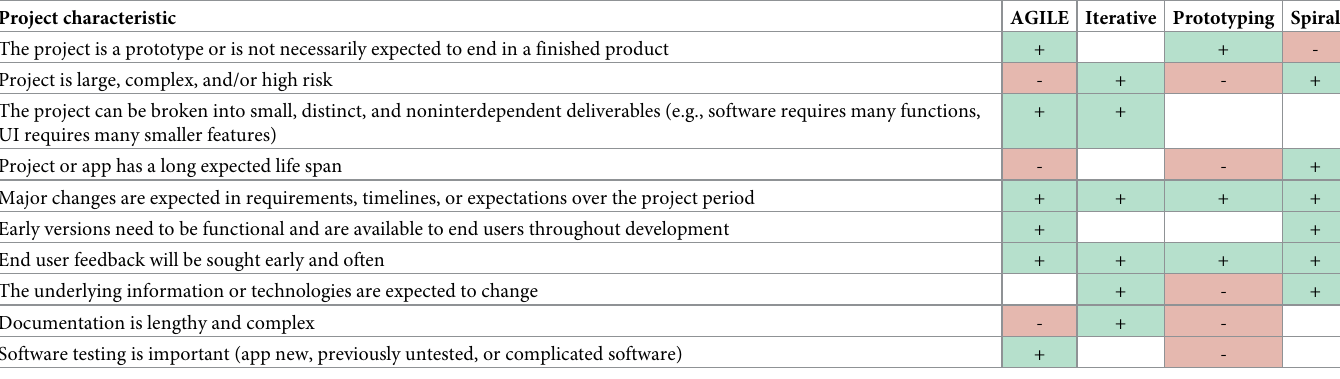
Table 2. A brief guide for identifying workflow models most appropriate for a SWApp